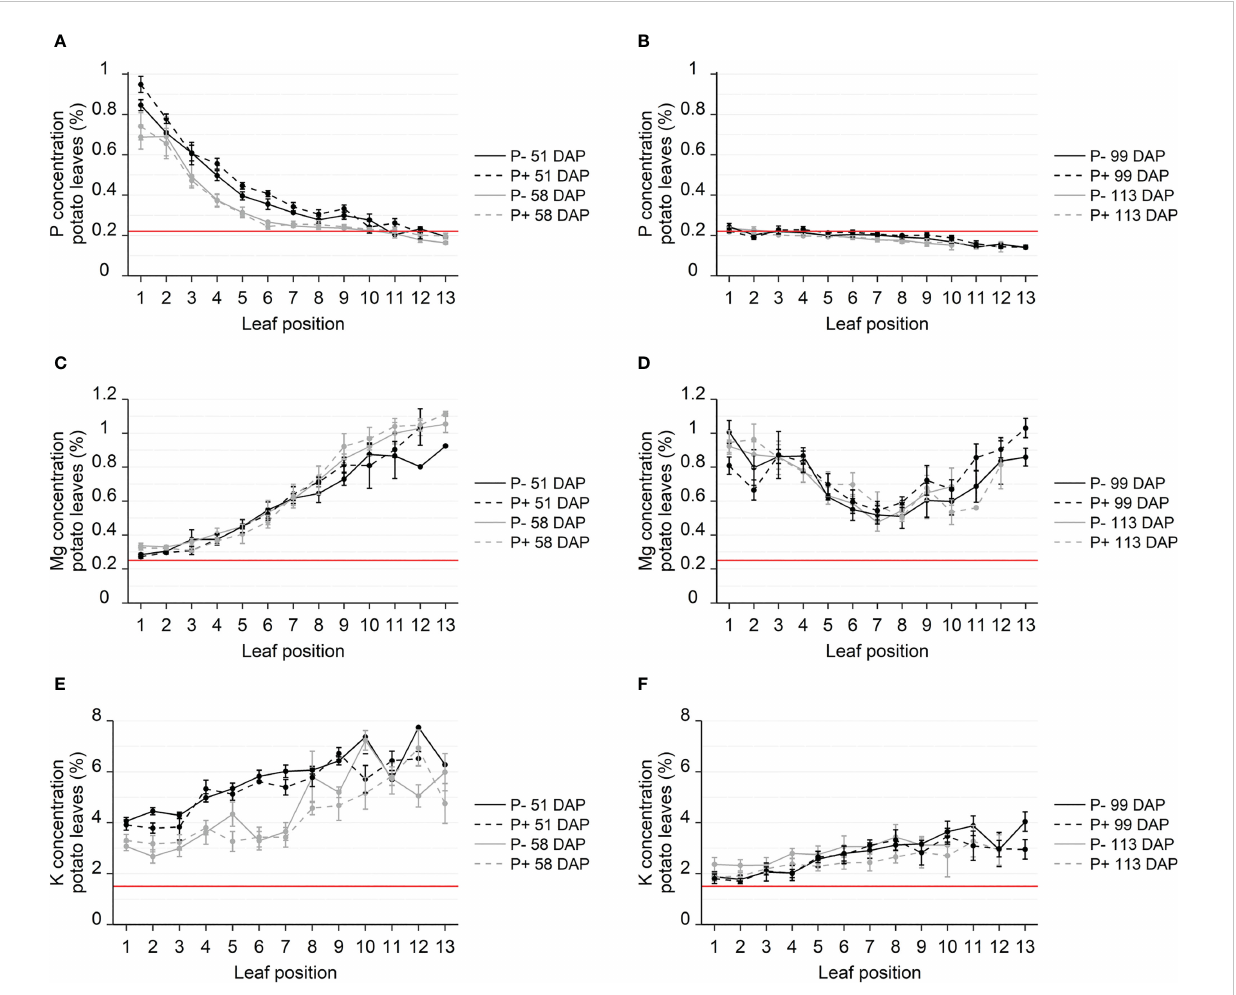
FIGURE 2 Concentration of P (A, B) , Mg (C, D) and K (E, F) in leaves from fi eld grown potato. Leaves sampled from four replicate plants throughout the growing season, 51-113 days after planting (DAP), during tuber initiation (A, C, E) or tuber bulking (B, D, F) . Nutrient concentrations were analyzed using ICP-MS and reported in %. Leaf positions specify the location of the leaf on the plant with lower numbers being the topmost, younger leaves and higher numbers indicating increasing leaf age. Red lines show standard threshold values for de fi ciencies for each nutrient in potato. Error bars show SEM (n =